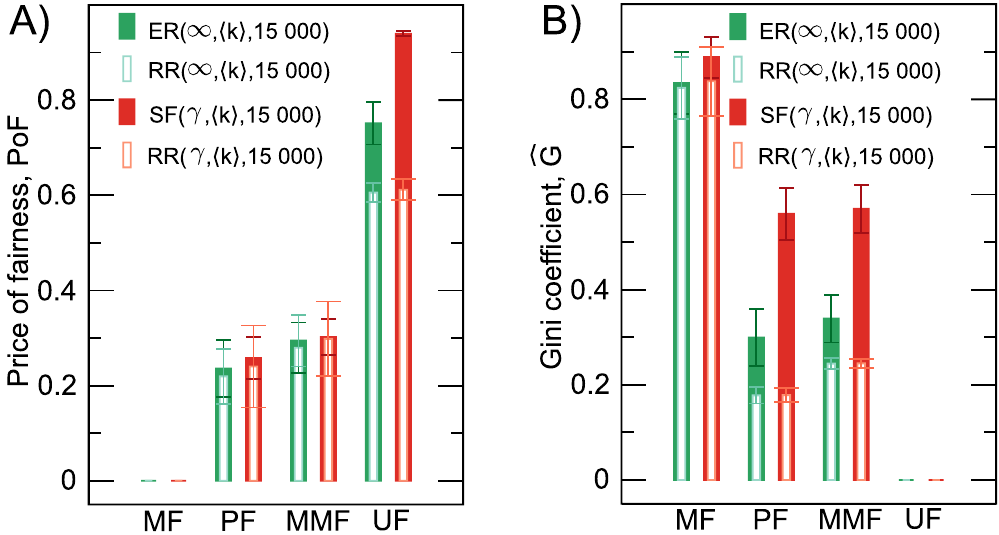
Figure 1. ( A ) Mean of the price of fairness (PoF) and ( B ) Gini coefficient of path flows for each congestion control algorithm in Erdös-Rényi and scale-free networks (and their random regular counterparts) with R = 15000 paths. For each network structure, we average over 20 randomly generated networks with N = 2000 nodes. Whiskers show the 95% confidence intervals. We average the price of fairness and Gini coefficient over the mean degree 〈 k 〉 = {3, 4, 5, 6, 7, 8} and the power-law exponent γ = {2.1, 2.3, 2.5, 2.7, 2.9} for scale-free (SF( γ , 〈 k 〉 , R )) and the corresponding random regular (RR( γ , 〈 k 〉 , R )) networks, but only over 〈 k 〉 for Erdös- Rényi (SF( γ = ∞ 〈 k 〉 , R )) and the corresponding random regular (RR( ∞ , 〈 k 〉 , R ))